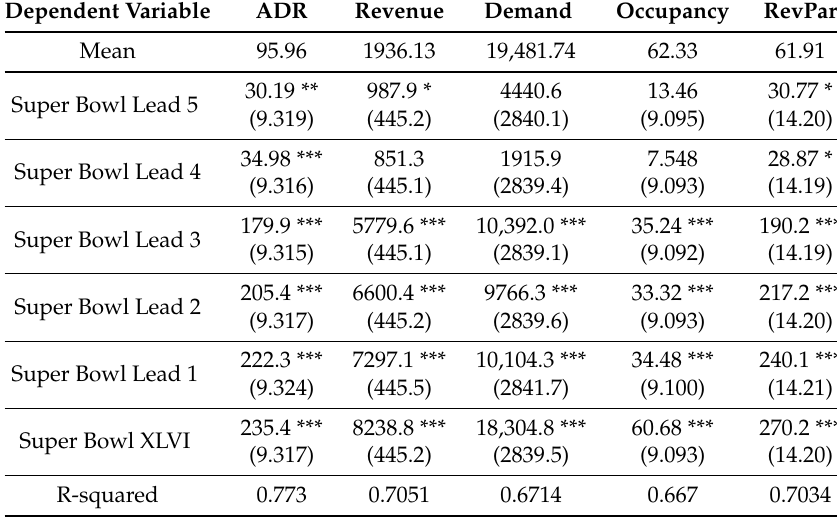
Table 13. The impact of Super Bowl XLVI on the hotel